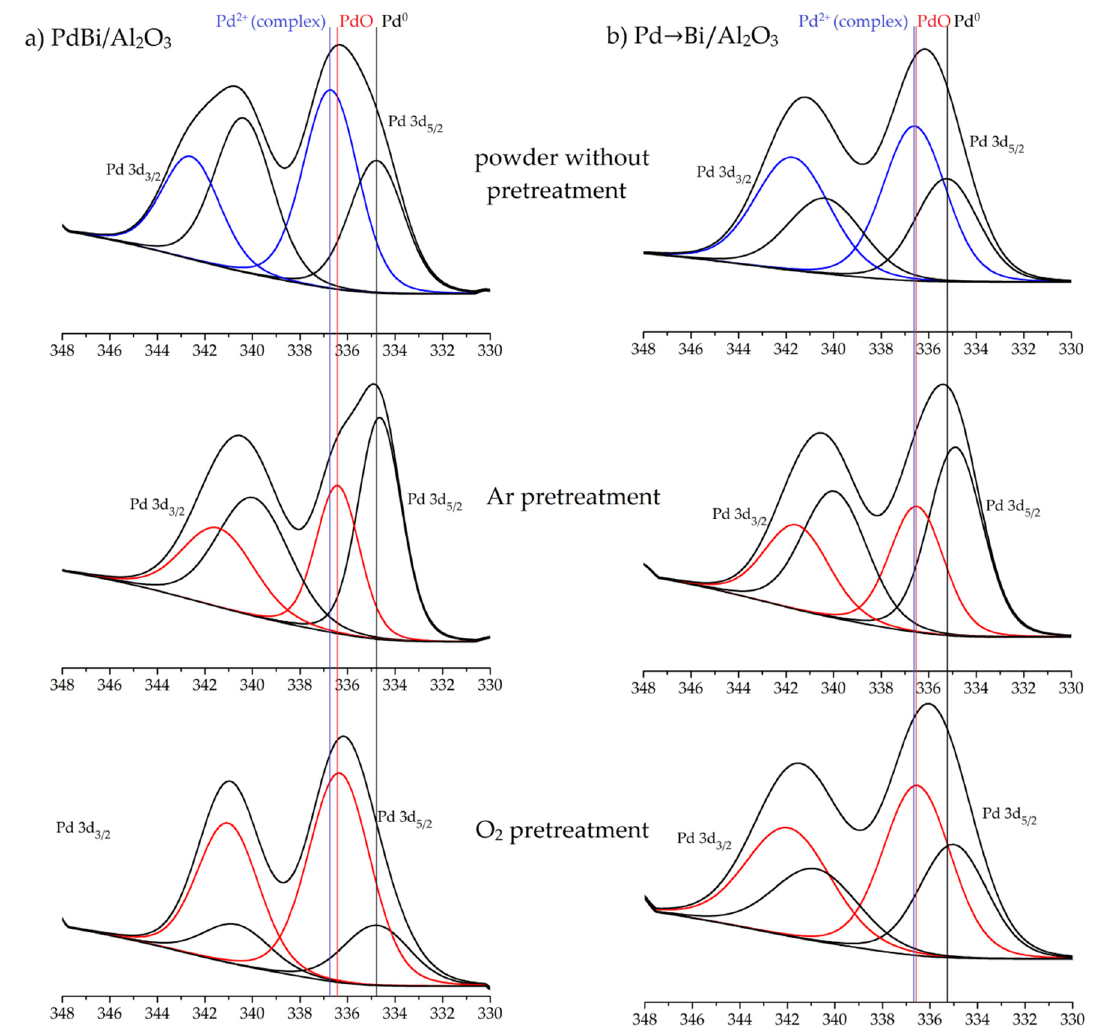
Figure 8. X-ray photoelectron spectra of the Pd 3d line of the catalyst surface after each stage of / Al → Bi / Al 2 O 3 , ( b ) Pd 2 O 3 preparation ( a ) PdBi/Al 2 O 3 , ( b ) Pd → Bi/Al 2 O 3 . preparation ( a ) PdBi